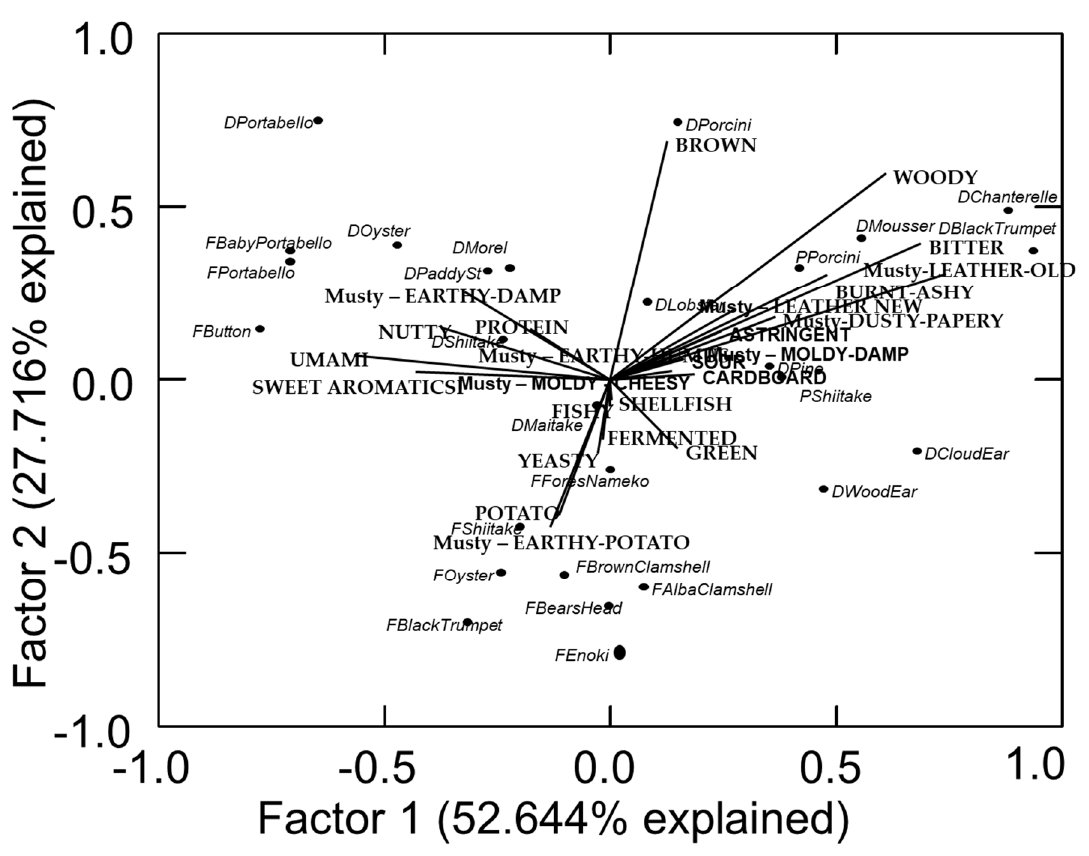
Figure 1. Principal component map of flavor notes and mushroom broth (fresh and reconstitued dried). 10